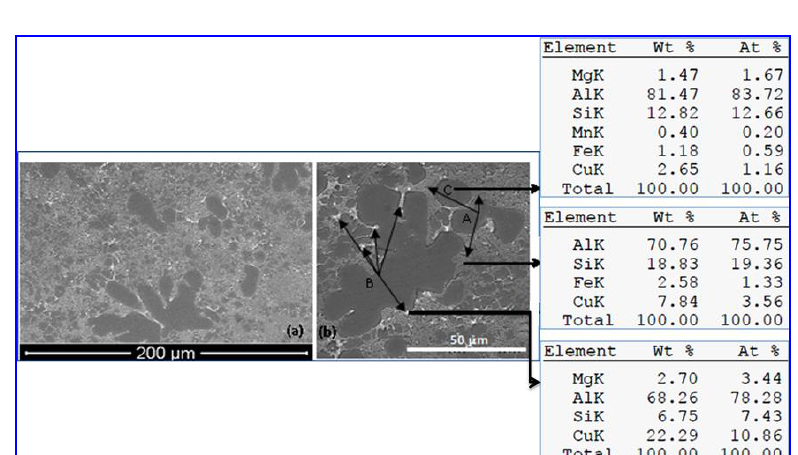
Figure 14: Representative SEM microstructure of longitudinal section of connector 1 in different magnifications (a,b). Etchant: Keller’s reagent.